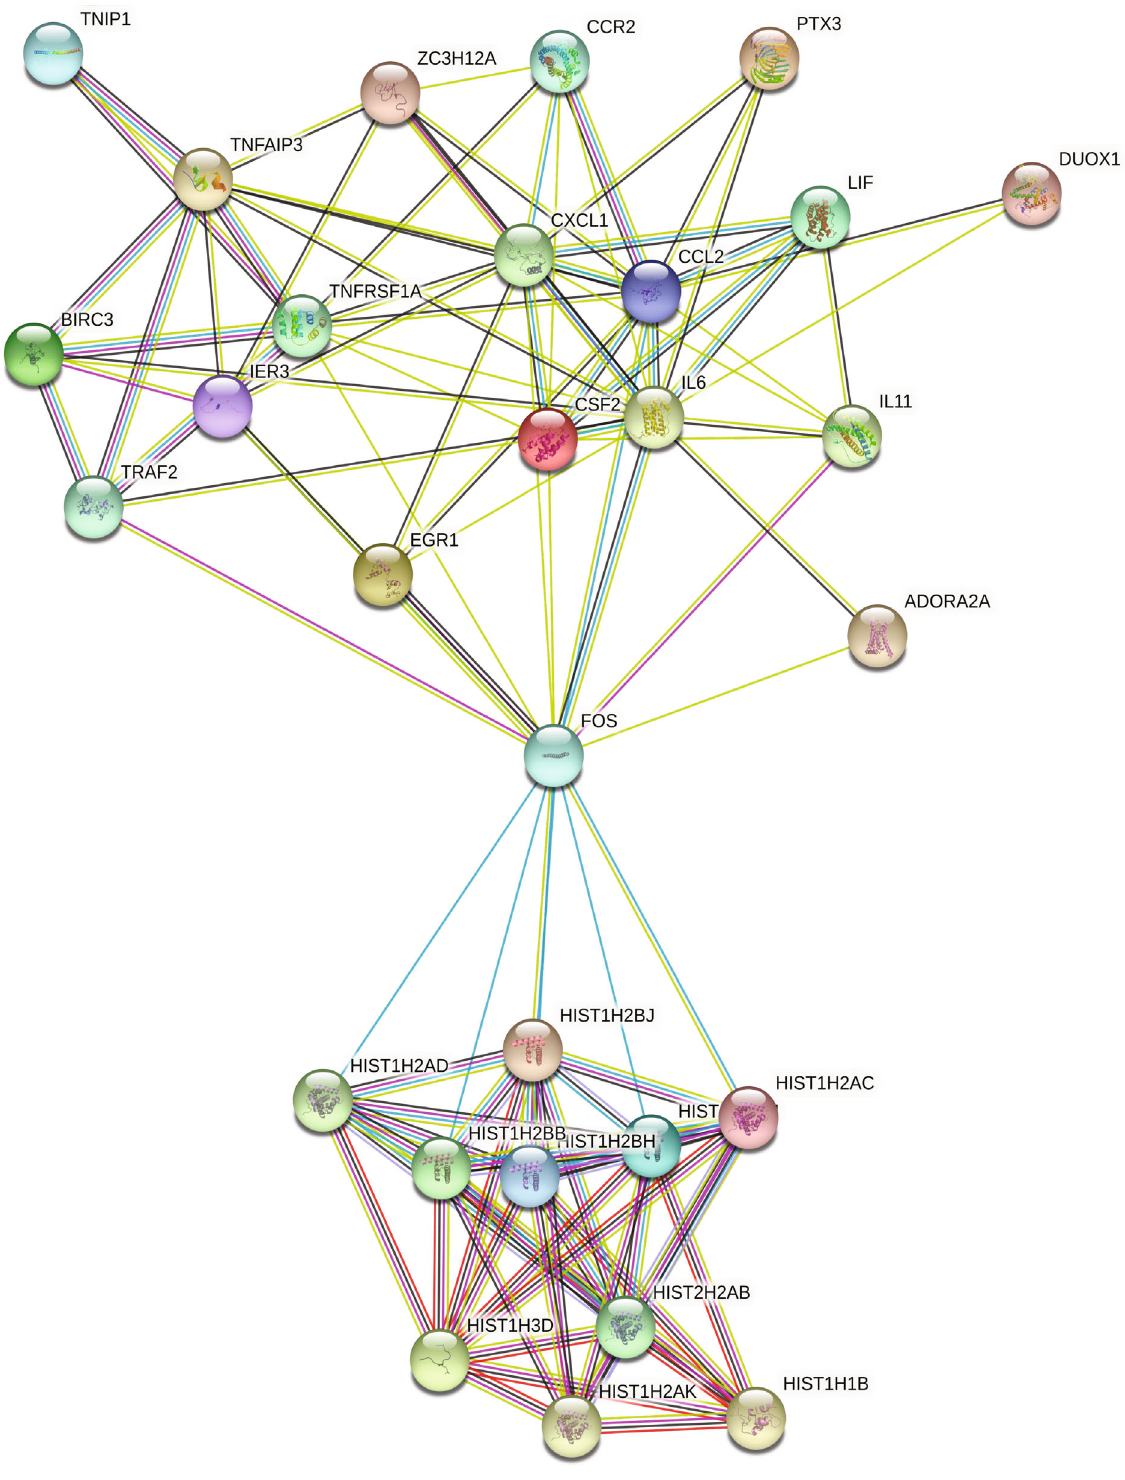
Figure 4: Overview of protein-protein-interacting networks inferred from overexpressed genes in the monkeypox-infected Macaca mulatta kidney epithelial (MK2) cell model and the human immortal epithelial cancer (HeLa) cell model. (a) Similar transcriptome patterns obtained from the GSE21001 and GSE36854 datasets were fi ltered by a Venn diagram. Shortlist of the top 1% of upregulated genes shared by the two monkeypox-infected models. (b) Distribution of 24 coregulated genes inferred from the above shortlist, presented using box plot visualizations. (c) STRING analyses revealed the protein-protein-interacting network of the 24 co-regulated genes, separated by clusters in di ff erent colors. Colored nodes represent 24 target genes as input, while gray nodes represent the corresponding